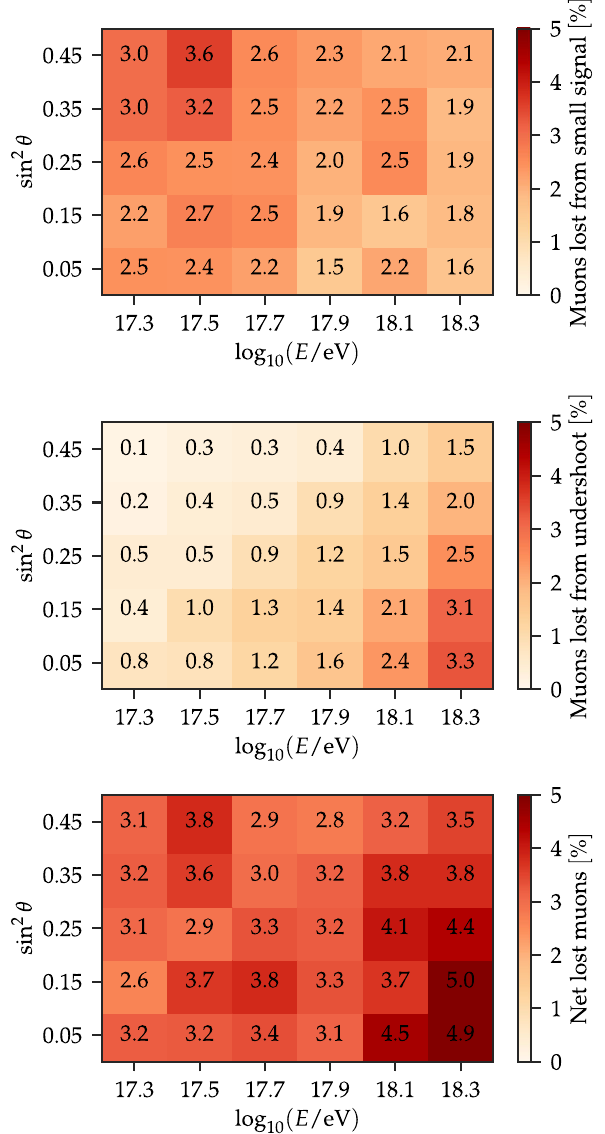
Fig. 4 Averagepercentageofmissedmuoncountsduetosignalsbeing to small or too short (upper panel), due to undershoot (middle panel), and the sum (lower panel), as a function of the logarithmic energy and of the sine square of the zenith angle. We use proton initiated air-shower simulations with the distribution of distances of an hexagonal array